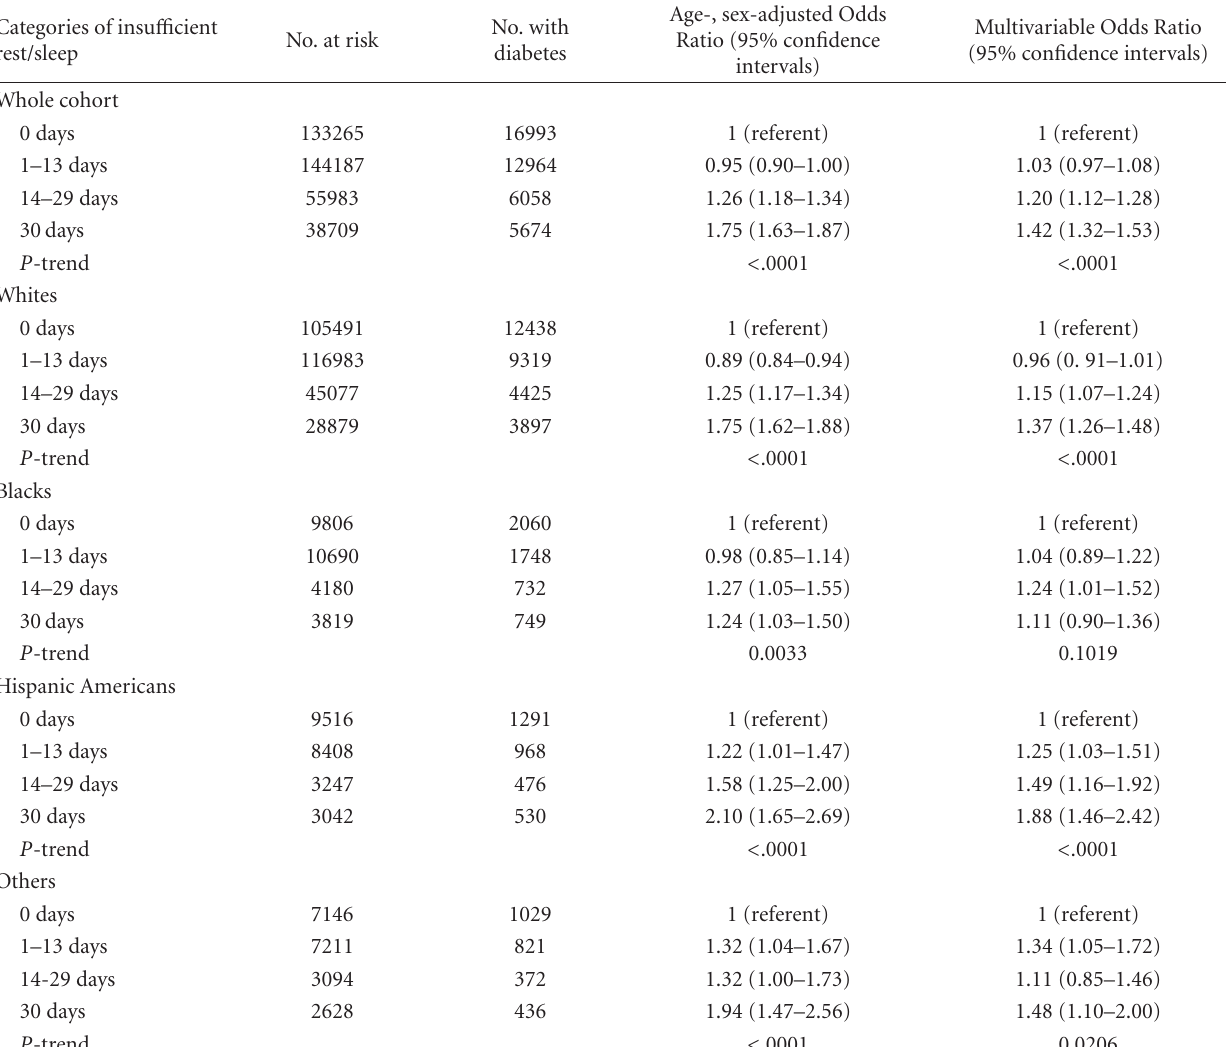
Table 3: Association between insu ffi cient rest/sleep and diabetes